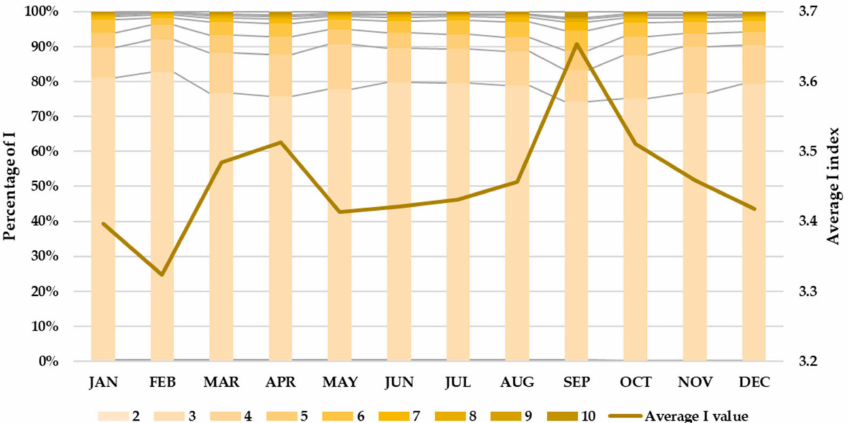
Figure 9. Distribution of the dynamic parameter’s rating for 10-year-averaged monthly impact of existing status of seawater intrusion